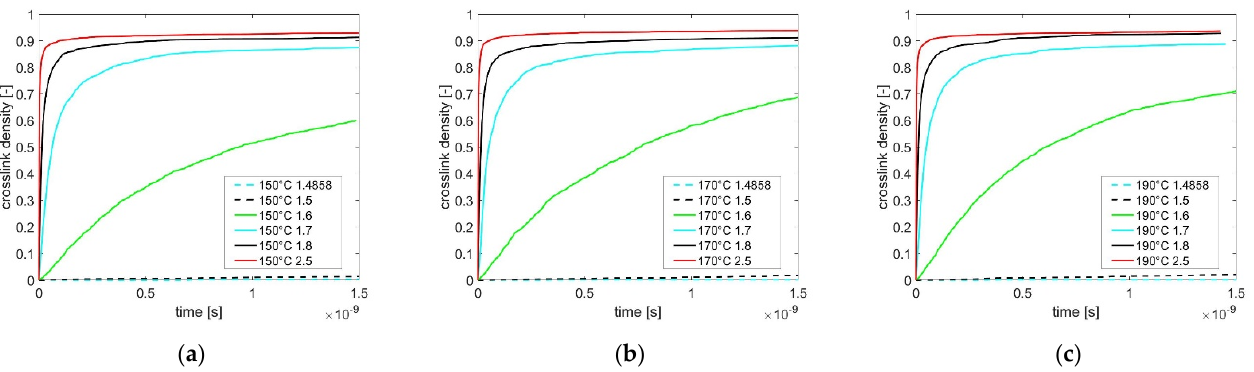
Figure 3. Curves of crosslink density depending on curing time concerning the influences of cutoff distances (1.48 Å → 2.5 Å) at ( a ) 150 °C, ( b ) 170 °C, and ( c ) 190 °C.